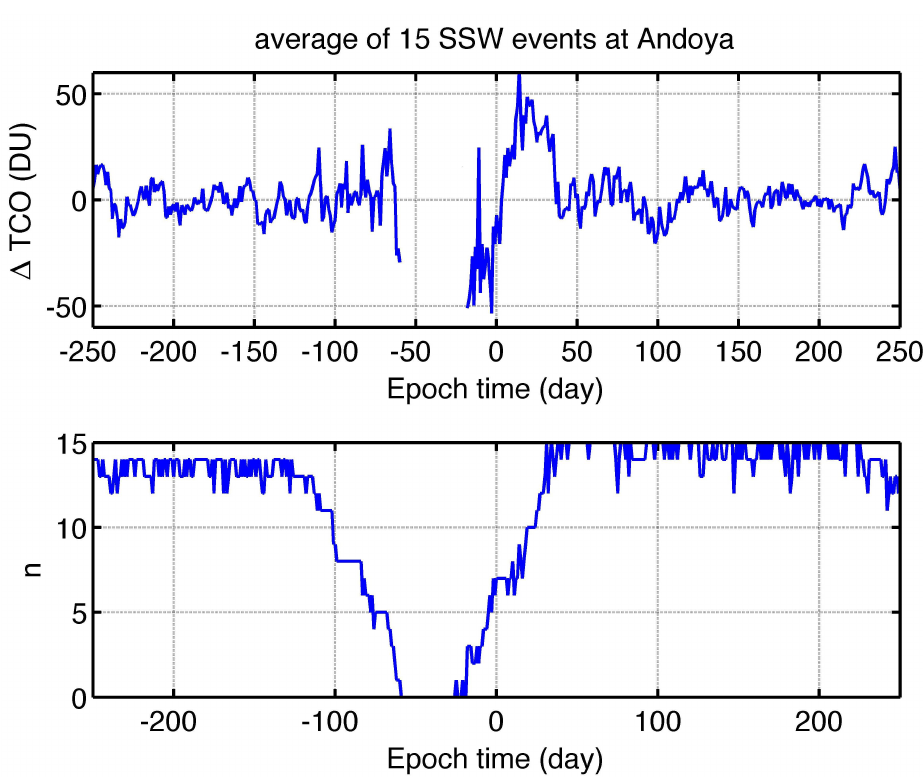
Figure 4. Composite of 15 major SSWs at Andøya (GBcomb data). The lower panel shows the number of measurements which were averaged in the composite shown in the upper panel.